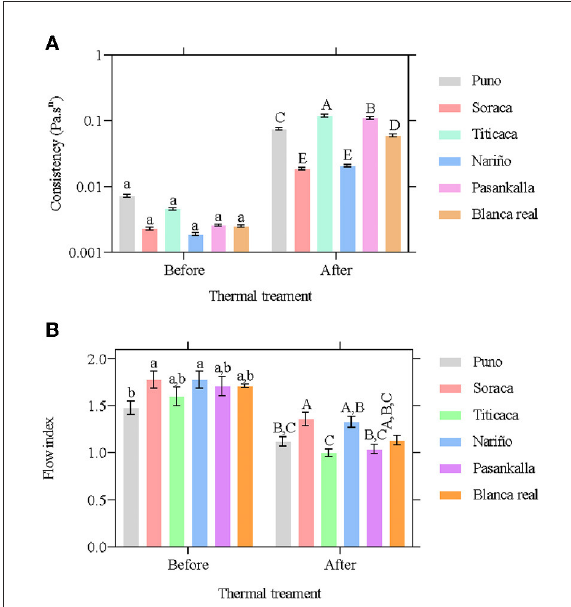
FIGURE2 Flow analysis before and after heating [Flow (A) and consistency (B) indexes]. The average and standard deviation are shown. Lower case letters indicate statistical differences between cultivars and upper letters represent significant differences for thermal